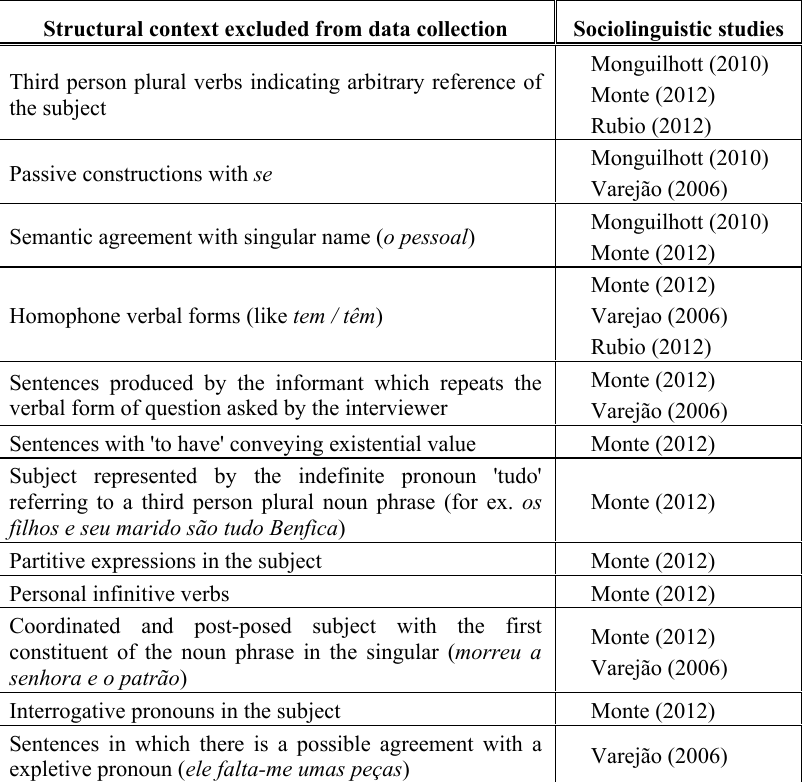
Table XXIV: Criteria for excluding data in